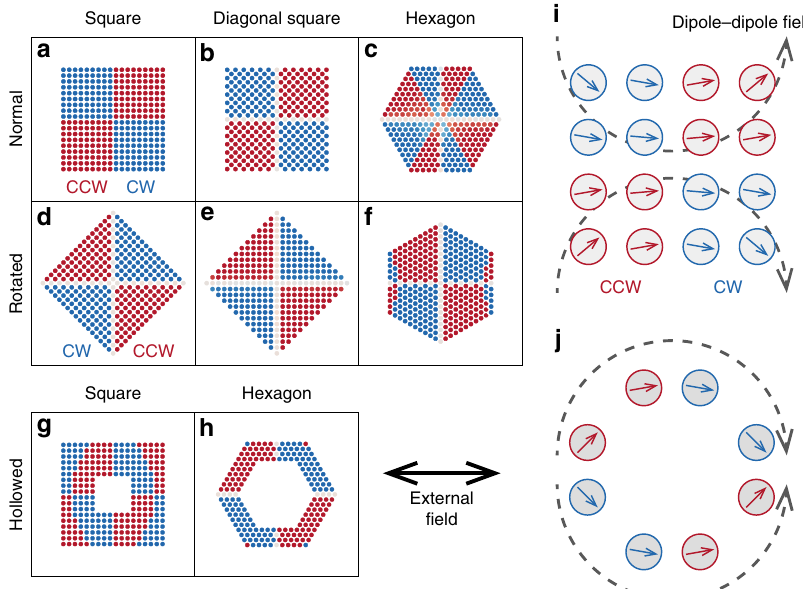
Fig. 5 Collective rotational patterns with different grid con fi gurations. a – h Patterns with different grid con fi gurations; the simulations performed for α ¼ 5 : 0 and β ¼ 0 : 05 for all con fi gurations. Red circles represent rotors that rotate counter-clockwise, while blue circles show clockwise rotation. Gray shows a rotor that has no rotational preference. i , j Schematics showing the relation between the global grid shape and the rotational